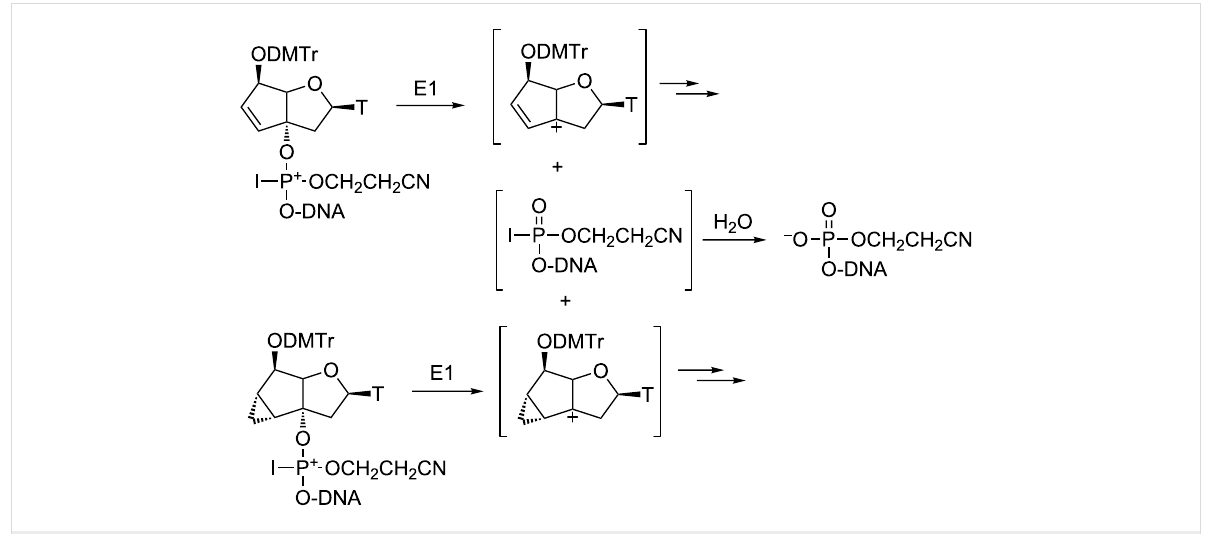
Scheme 3: Pathways for elimination of the modified nucleotides during the oxidation step in oligonucleotide